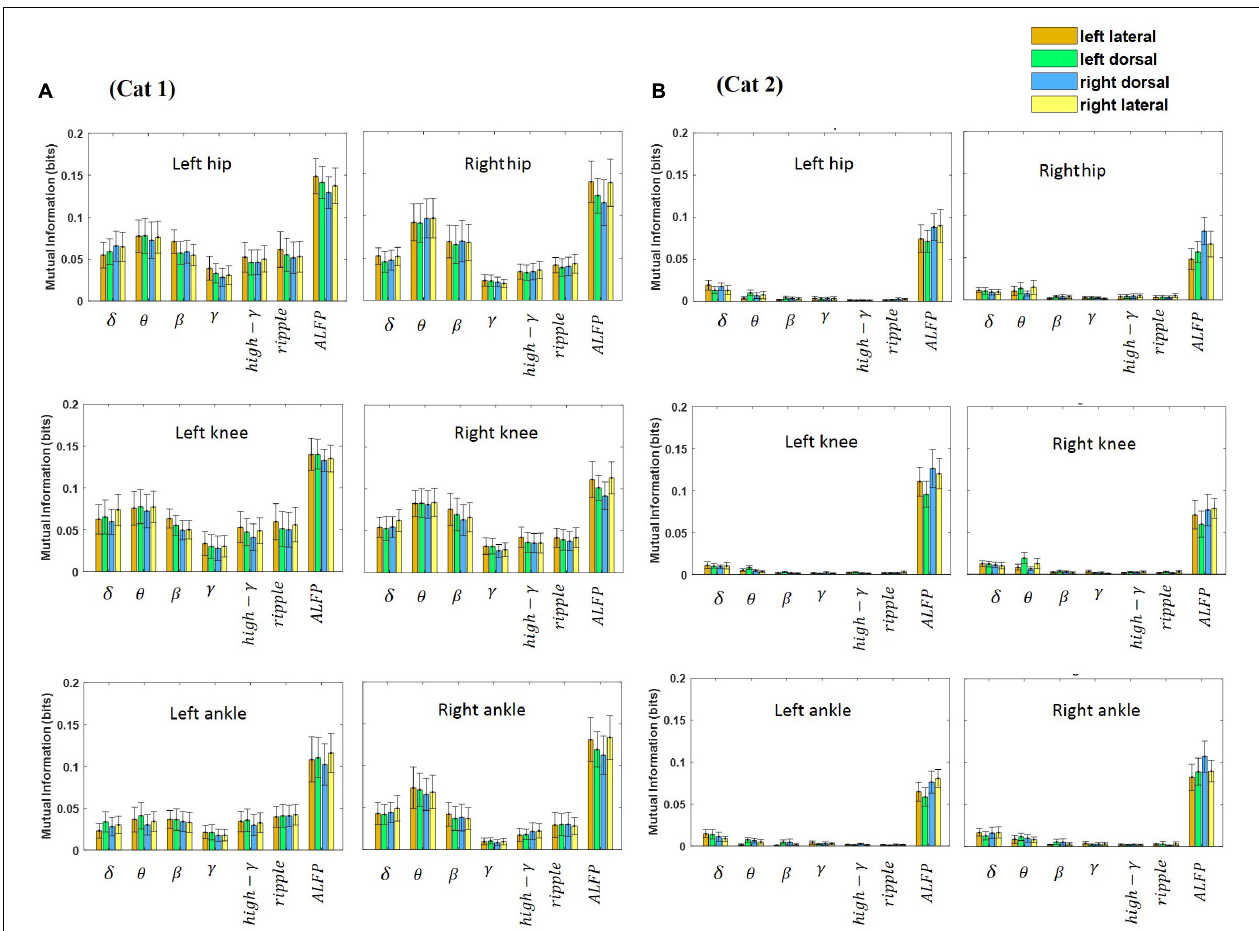
FIGURE 8 | Average of mutual information between each feature and each joint angle (i.e., hip, knee, and ankle) for the left and right legs. The features were extracted from each channel and consisted of the LFP envelope at different frequency bands and the amplitude of LFP signal. The error bar on each bar graph represents the standard deviation. The results were obtained from cat 1 (A) and cat 2 (B)